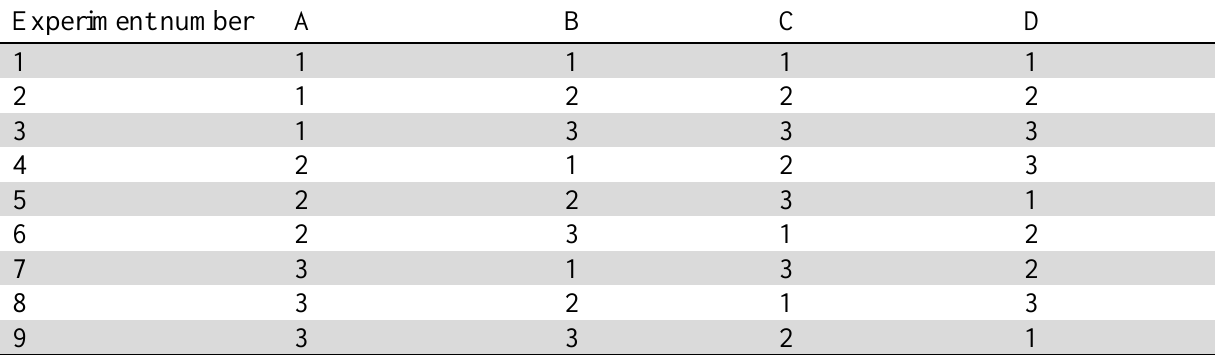
Layout of L 9 orthogonal